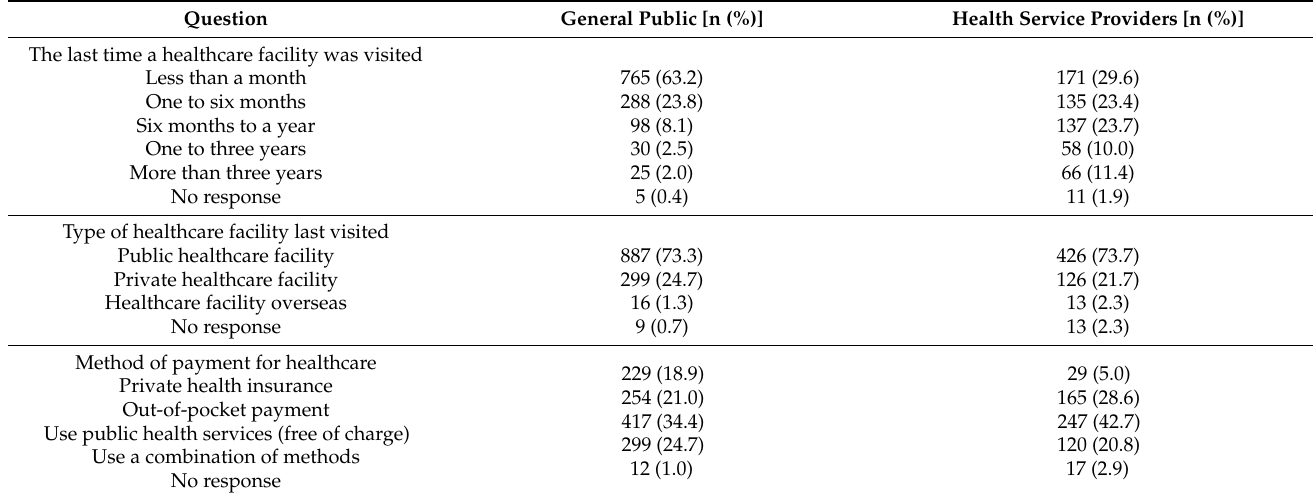
Table 4. Respondents’ care-seeking behaviour and their last encounter with the health